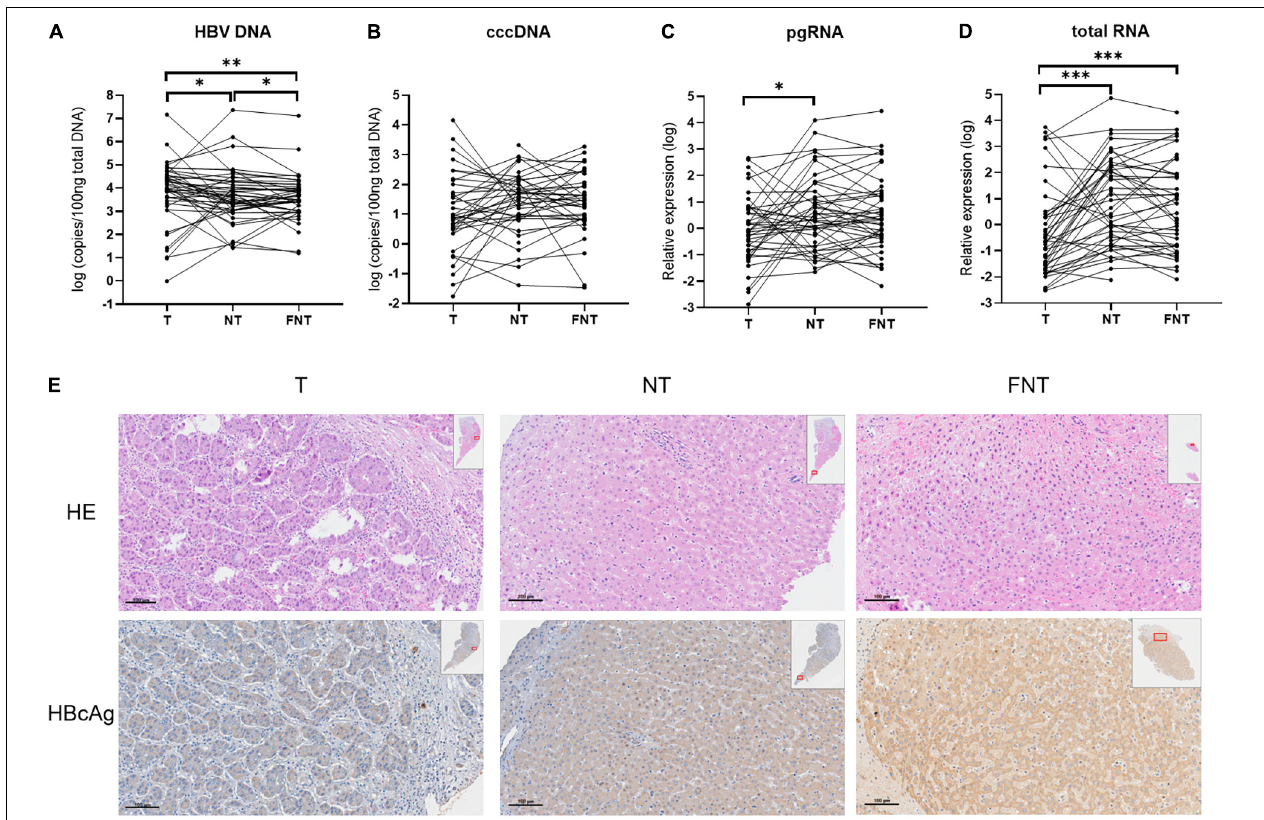
FIGURE 1 | Comparisons of HBV markers among T, NT, and FNT compartments. Dot plots of (A) HBV DNA, (B) cccDNA, (C) pgRNA, and (D) total RNA levels. (E) Immunohistochemical analysis of HBcAg expression from the same patient. Statistical analysis was performed by Wilcoxon signed rank test. ∗ p < 0.05; ∗∗ p < 0.01; ∗∗∗ p < 0.001. T, tumor; NT, adjacent non-tumor; FNT, distal non-tumor. Lines of histogram plots means average